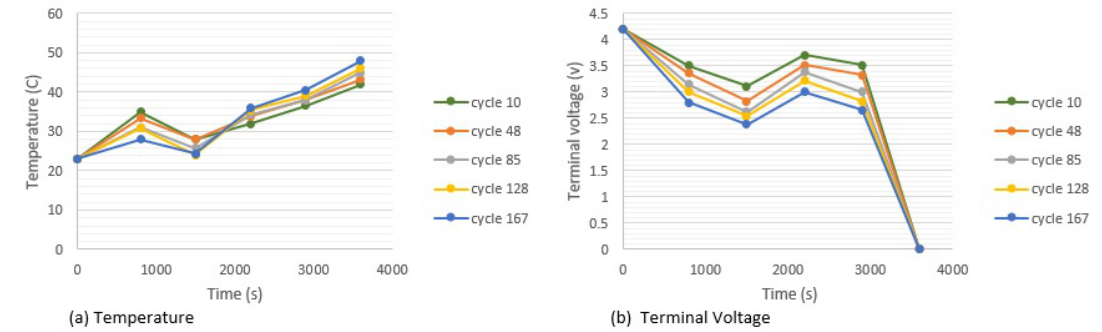
Figure 6. The voltage and temperature changes.